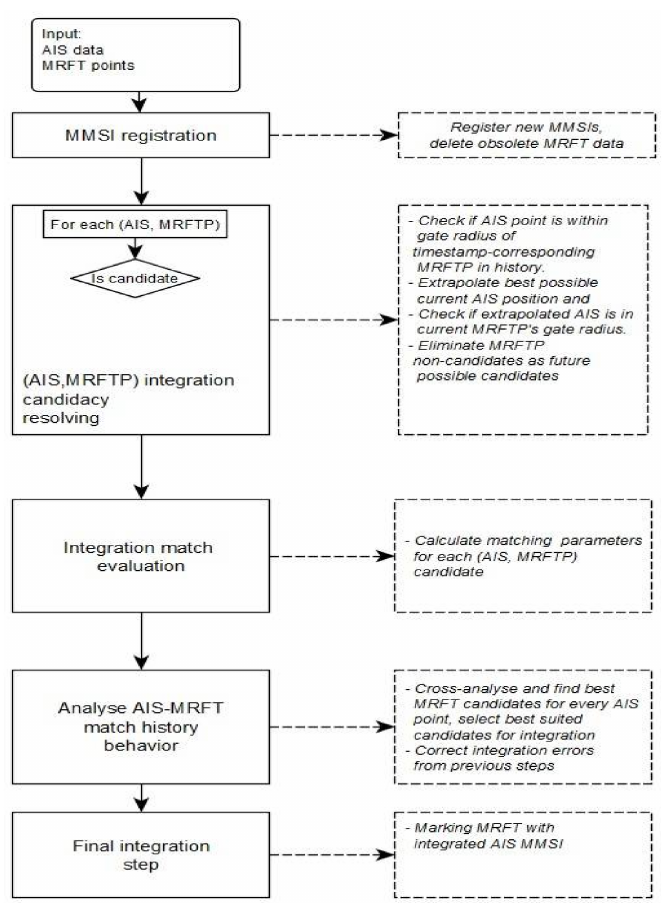
Figure 2. Steps of automatic identification system-multi-radar fusion track (AIS-MRFT)